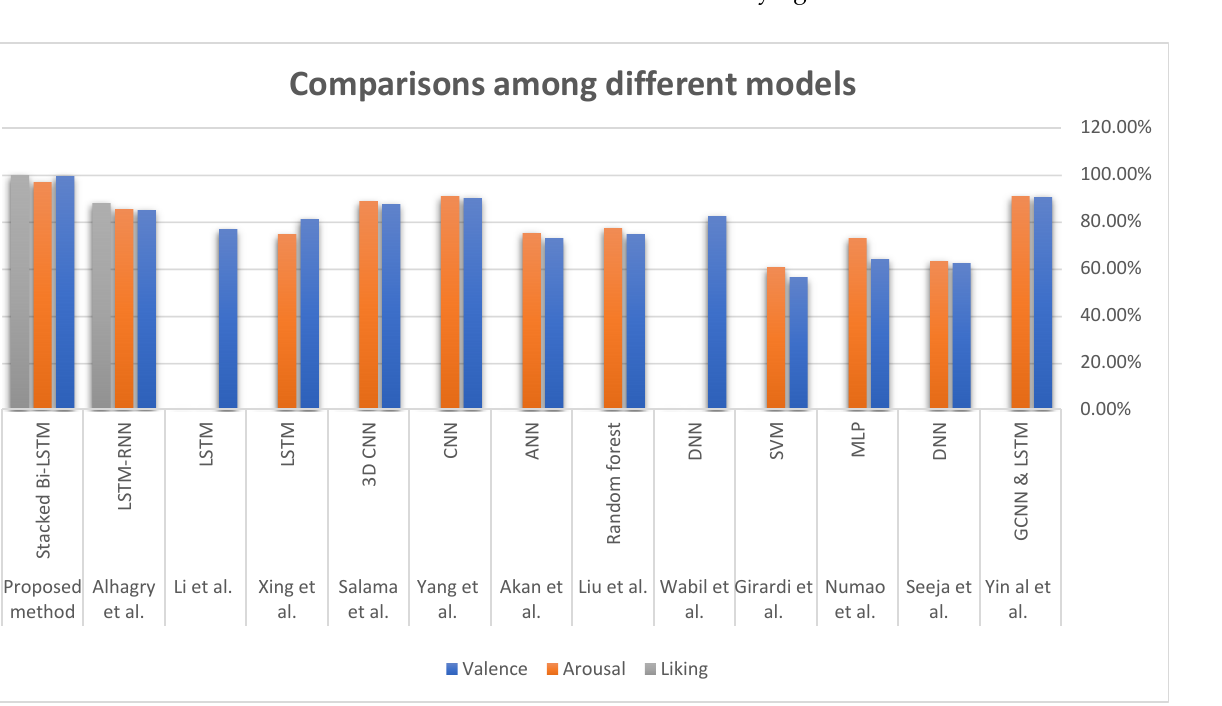
Figure 24. Comparisons among different emotion recognition models [4,17,18,22,25,28,57–62]. Further, the feature extraction process is vital in BCI applications. Therefore, in this experiment, various feature extraction techniques were selected, such as statistical features, wavelet features, and the Hurst exponent, giving a total number of 68